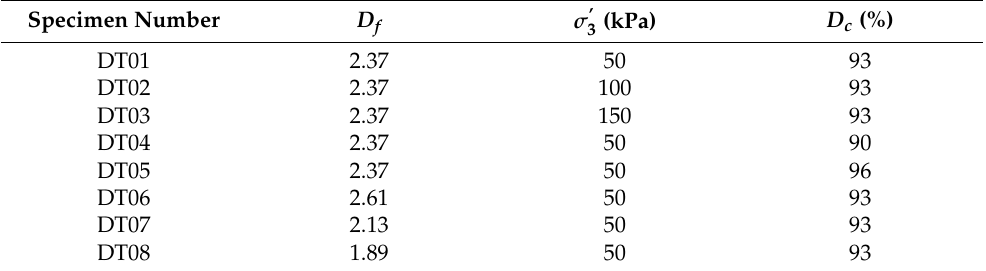
Table 1. Test scheme design.